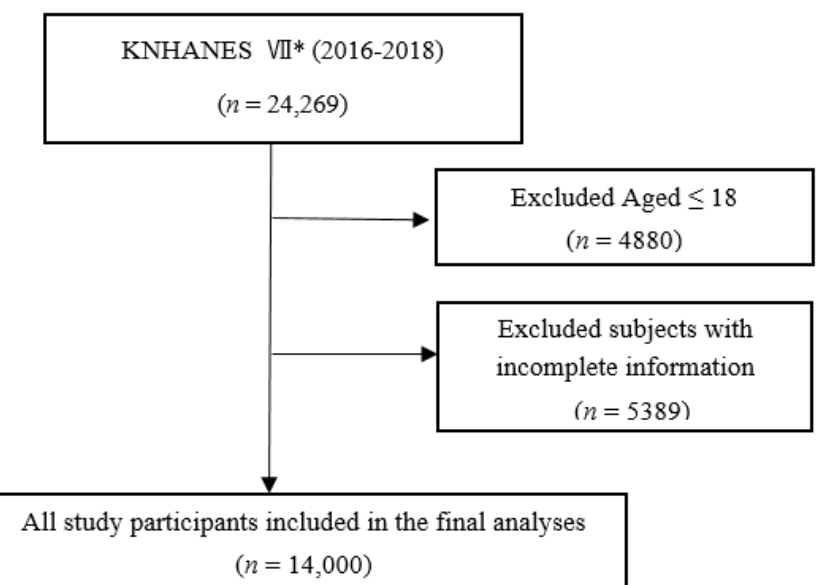
Figure 1. Flow chart of the study population. * The Seventh Korea National Health and Nutrition Examination Survey.